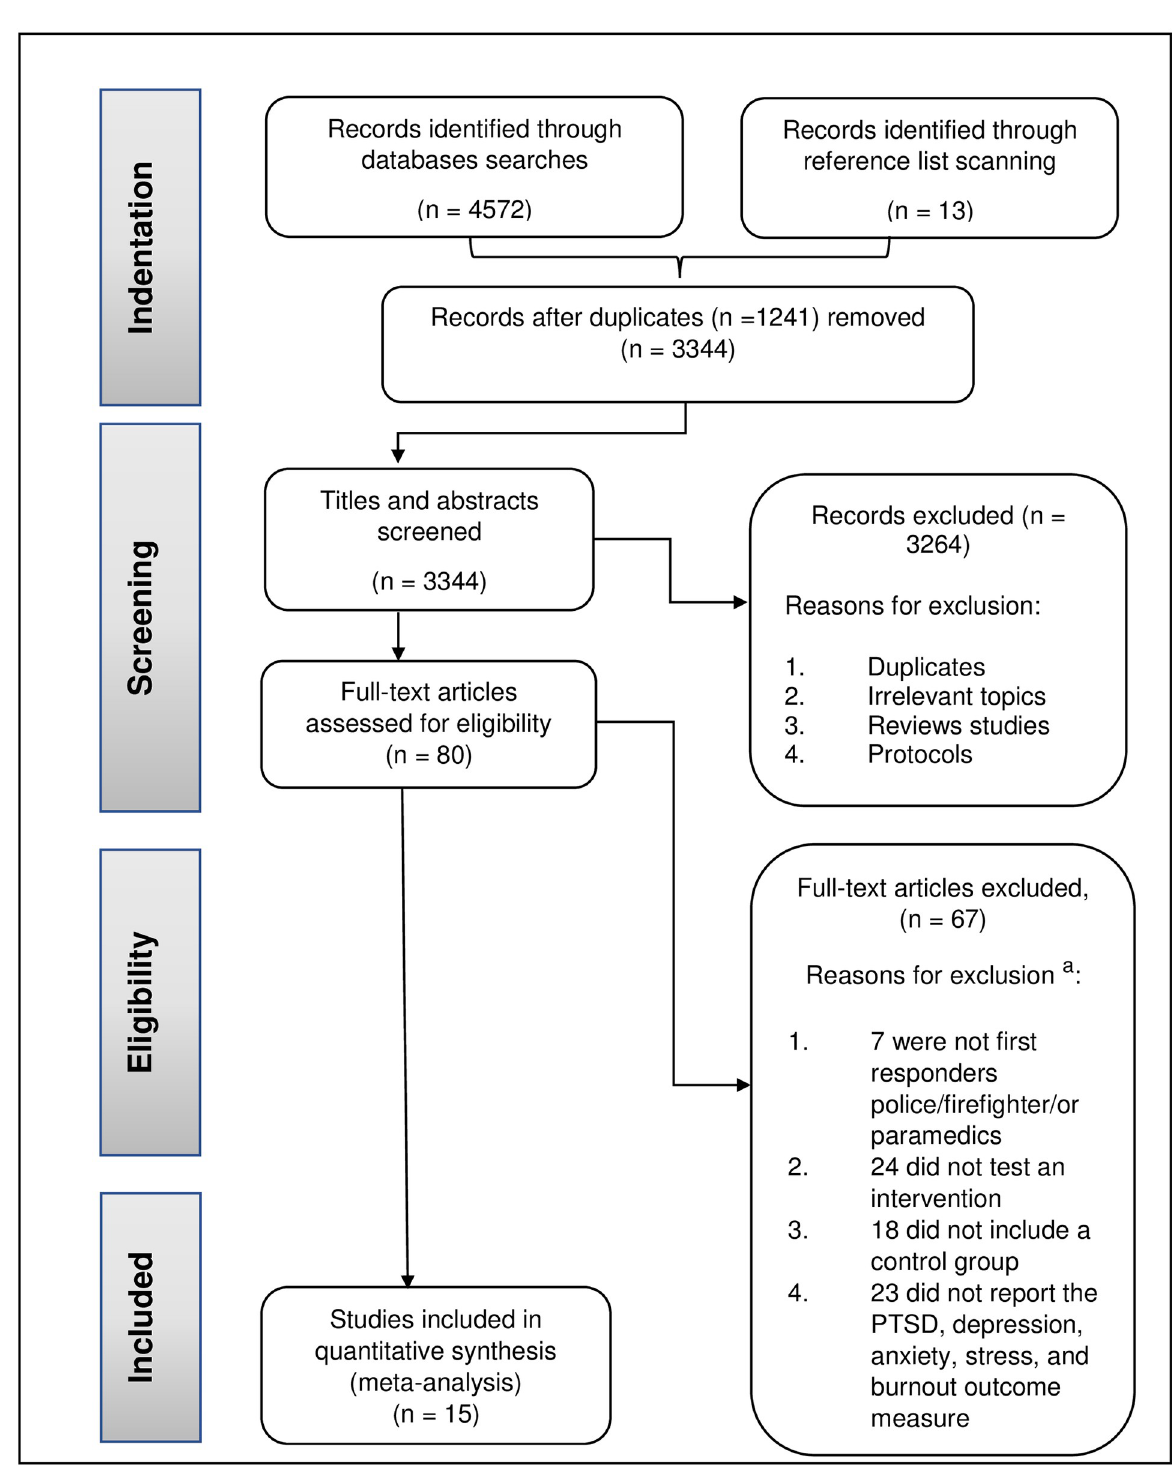
Fig 1. Flow diagram of article selection. a Some studies were excluded for more than one reason so the total studies do not equal 66.